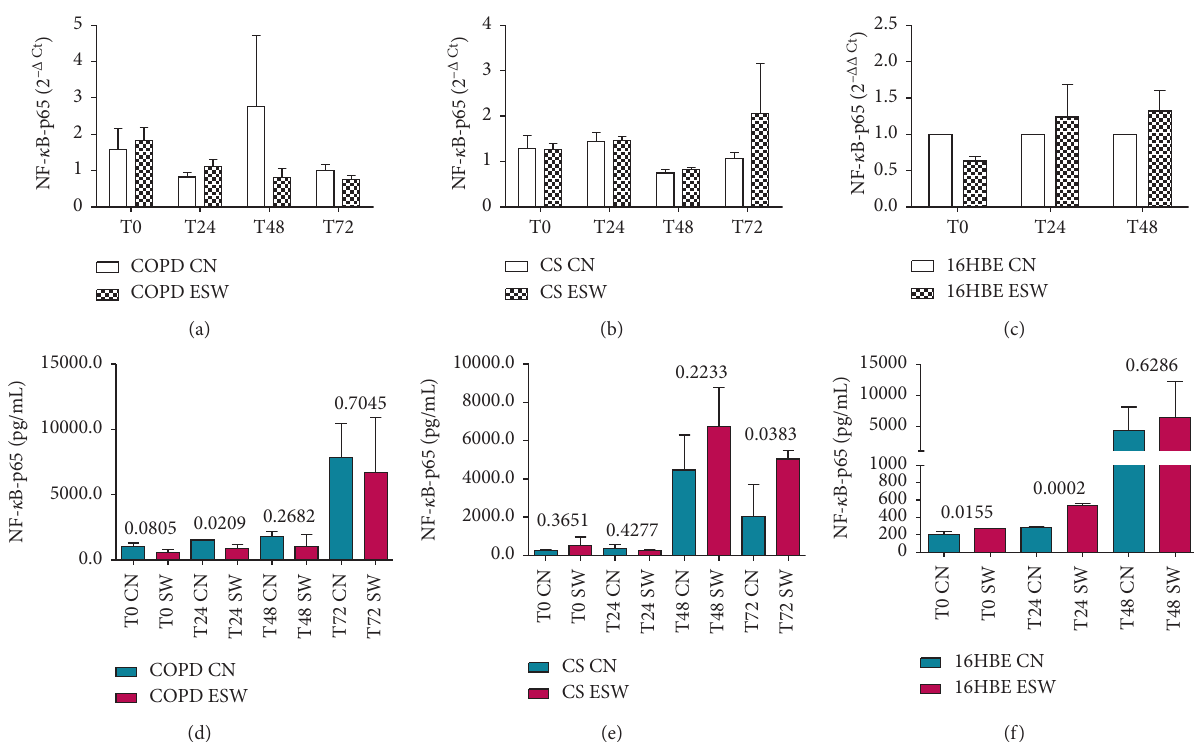
Figure 7: NF- κ B-p65 mRNA (a, b, c) and protein (d, e, f) expression after ESW treatment in primary bronchial fibroblasts of COPD patients (a, d), primary bronchial fibroblasts of control smokers (b, e), and bronchial epithelial cells (c, f). In bronchial epithelium (16HBE), NF- κ B- p65 increased at protein (panel f) level at 4 and 24h of exposure. In primary bronchial fibroblasts of COPD patients, NF- κ B-p65 decreased at protein level (d) at 24h. In primary bronchial fibroblasts of control smokers, NF- κ B-p65 increased at protein level ( e) at 72h. T -test was used for comparative purposes, and p values are reported in the